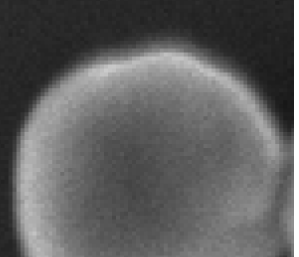
Figure 4. Particle border visualization with × 16